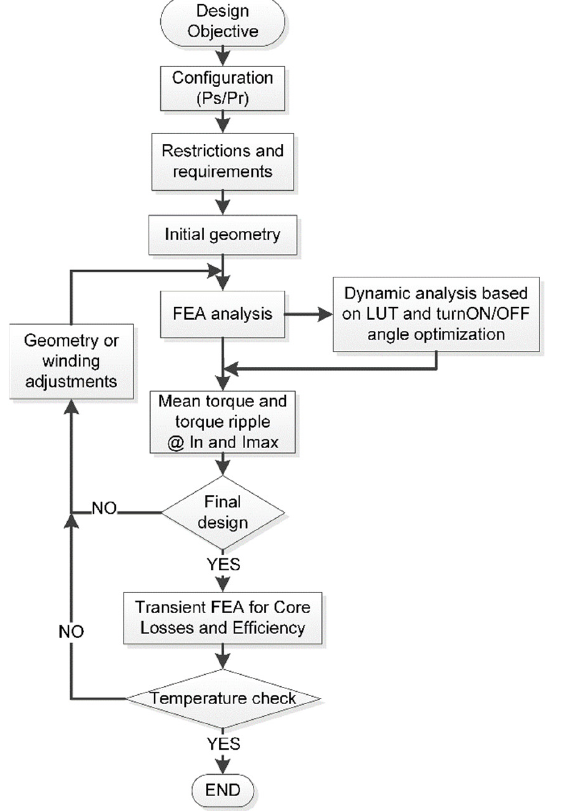
Figure 12. SRM design flow chart (LUT-look up table; I n and I max -nominal and maximum current values, respectively).